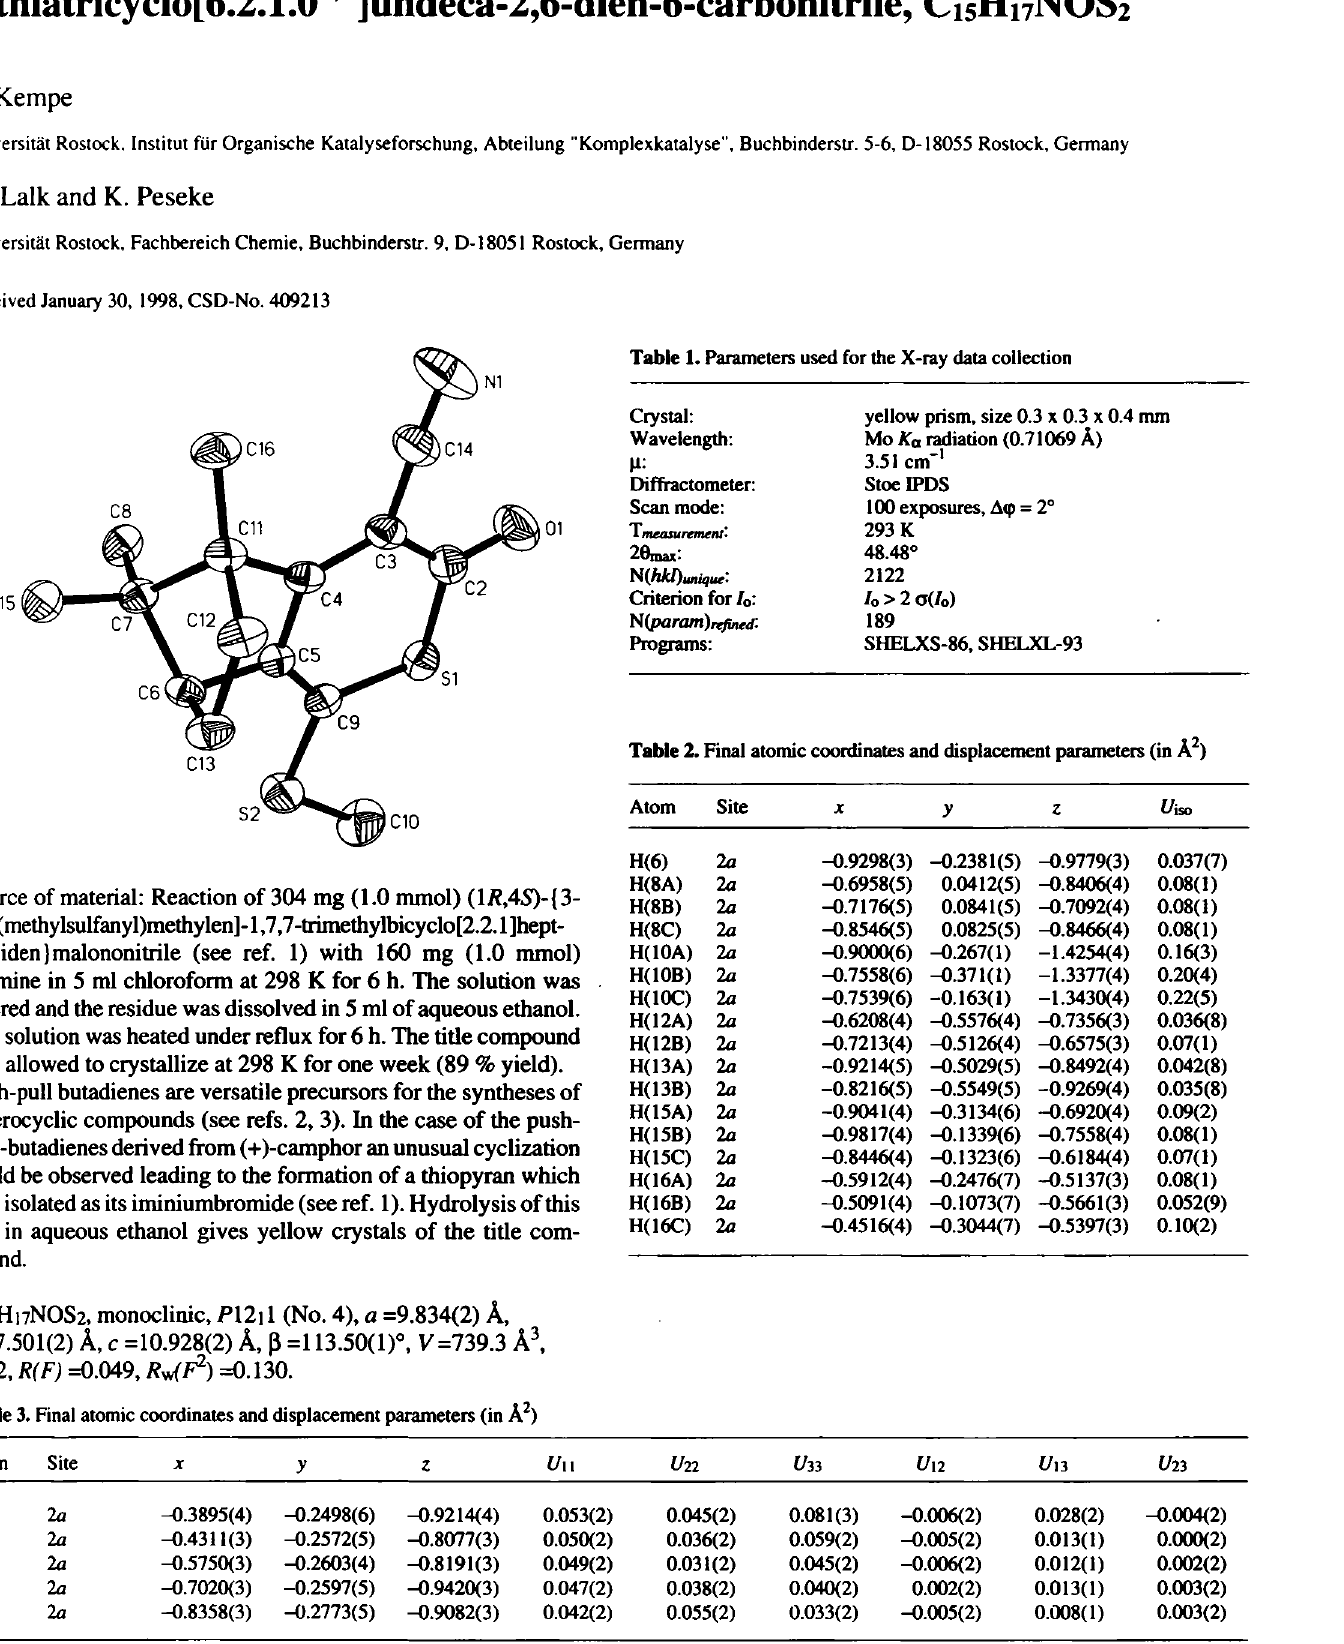
Table 3. Final atomic coordinates and displacement parameters (in Â^)